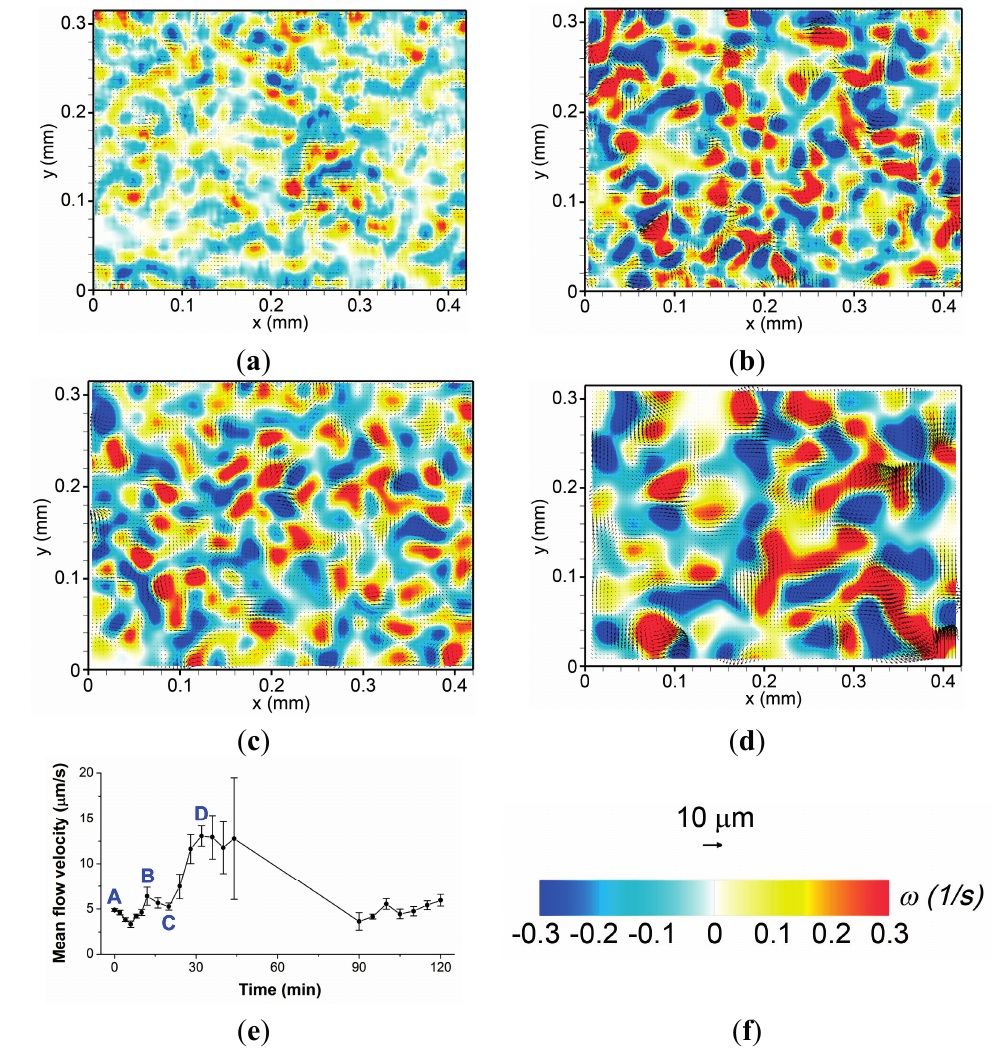
Figure 2. Instantaneous velocity (arrow) and vorticity (color) maps of swarm colony flow at the interior of the B. subtilis colony obtained by particle image velocimetry at ( a ) 0; ( b ) 12; ( c ) 20; and ( d ) 32 min after initiation of swarm motility; ( e ) Variation in the mean flow velocity with respect to time; and ( f ) Scales of the velocity vector and vorticity. Colors indicate the strength of relative vorticity, red for positive (counter-clockwise rotation) and blue for negative (clockwise rotation) vorticity,